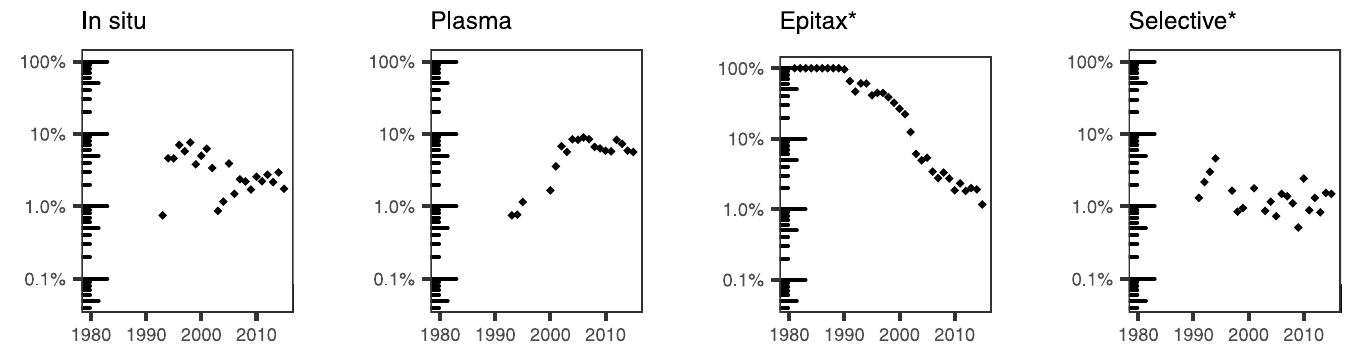
Fig 11. Percentage of ALD papers containing a specific word pertaining to the type of study or process in their titles.